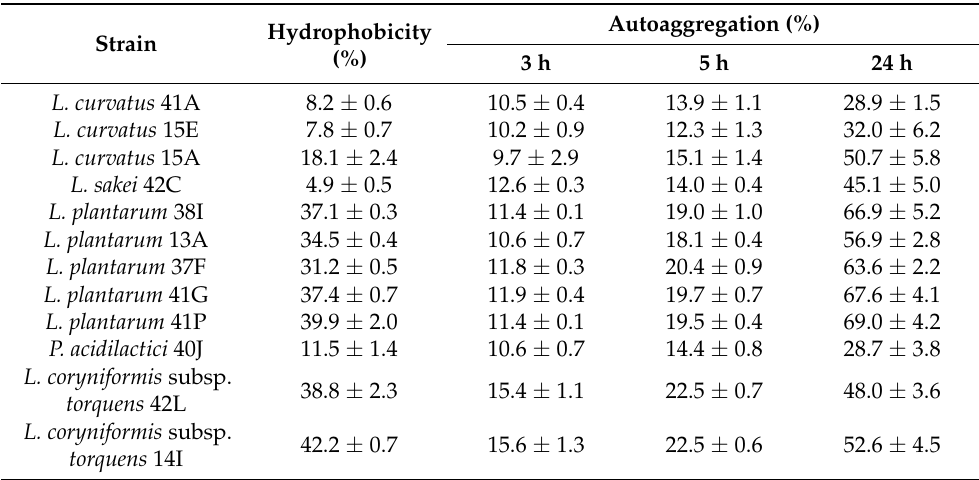
Table 4. Hydrophobicity (%) and autoaggregation (%) of LAB isolates. Results presented as mean ± standard deviation (SD) of three independent